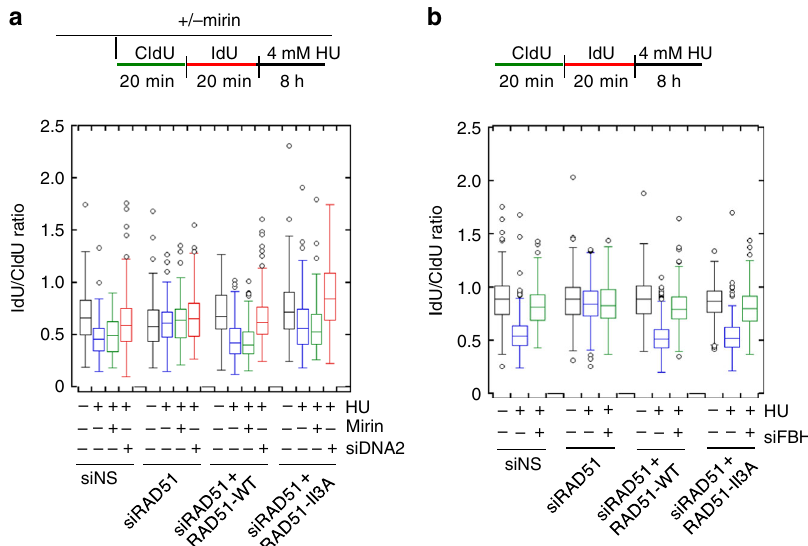
Fig. 3 Replication tract shortening after HU treatment requires DNA2 and FBH1 activity. a DNA2 depletion prevents replication tract shortening after treatment with 4 mM HU for 8 h. Box plot represents the IdU/CldU ratio of tracts measured in U2OS cells after the indicated treatment. b FBH1depletion prevents replication tract shortening after treatment with 4 mM HU for 8 h. Data represent at least 100 replication tracts from two independent experiments. Box plot represents the IdU/CldU ratio of tracts measured in U2OS cells after the indicated treatment. Lines represent the median for each set of measurements. Boxes represent 25th and 75th quartiles with Tukey whiskers (see methods for details). Values are presented as mean ± SD. Statistical signi fi cance was determined using Mann – Whitney test. Source data are provided as a source data fi